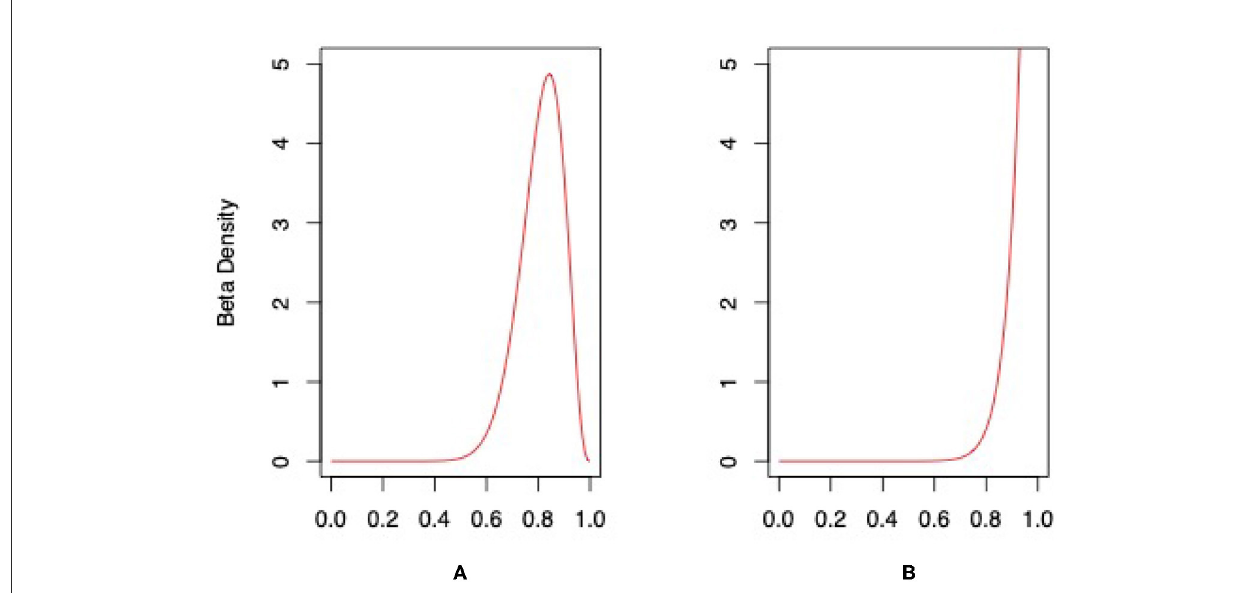
FIGURE4 Posterior distributions for photoacoustic test using (A) uniform conjugate prior and (B) high accuracy conjugate